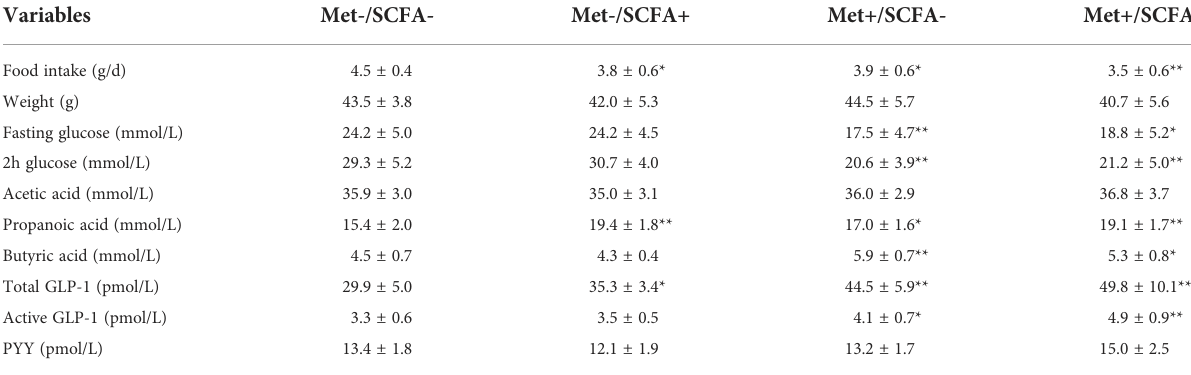
TABLE 2B Characteristics of mice in experiment B (after